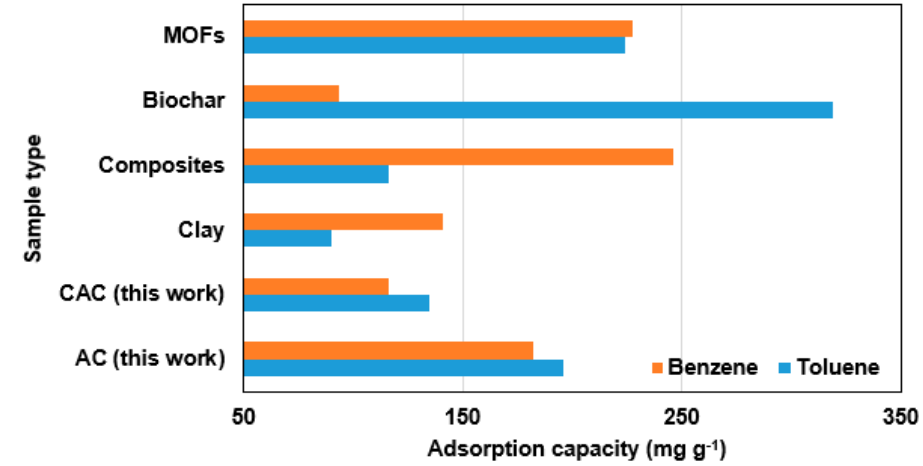
Figure 6. Adsorption capacity of selected VOCs by various sample types.